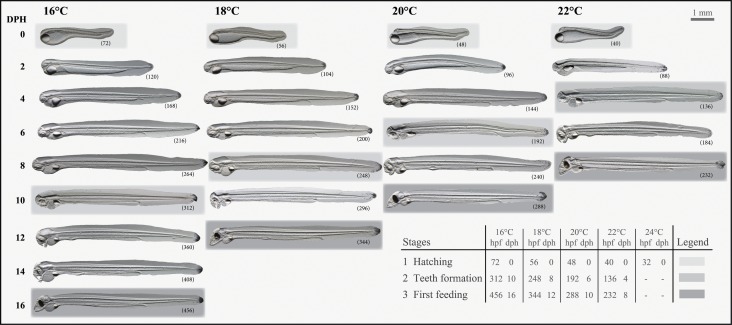
Timing of morphological features during development of larval European eel (Anguilla anguilla).Larval age presented in hours post-fertilization (hpf) and days post-hatch (dph) for five rearing temperature regimes. Across the different temperature treatments, Stage 1 represents the day of hatch, Stage 2 represents the timing of jaw/teeth formation, while Stage 3 represents the first-feeding stages.